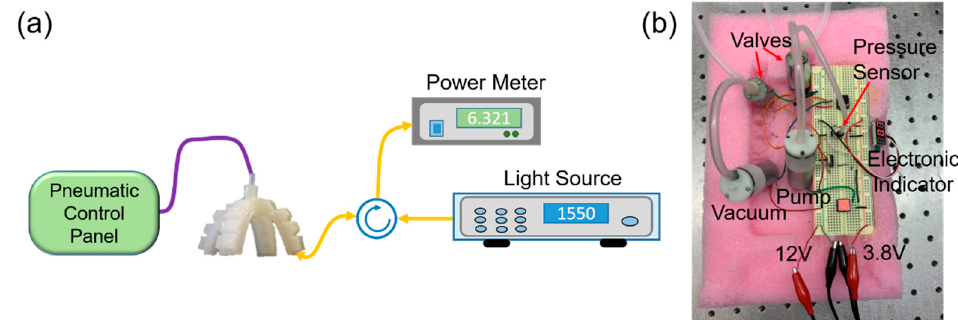
Figure 2. ( a ) Experimental setup for testing the FBG embedded soft robotic gripper. Yellow lines: optical paths. Purple line: air tube; and ( b ) picture of the pneumatic control panel.